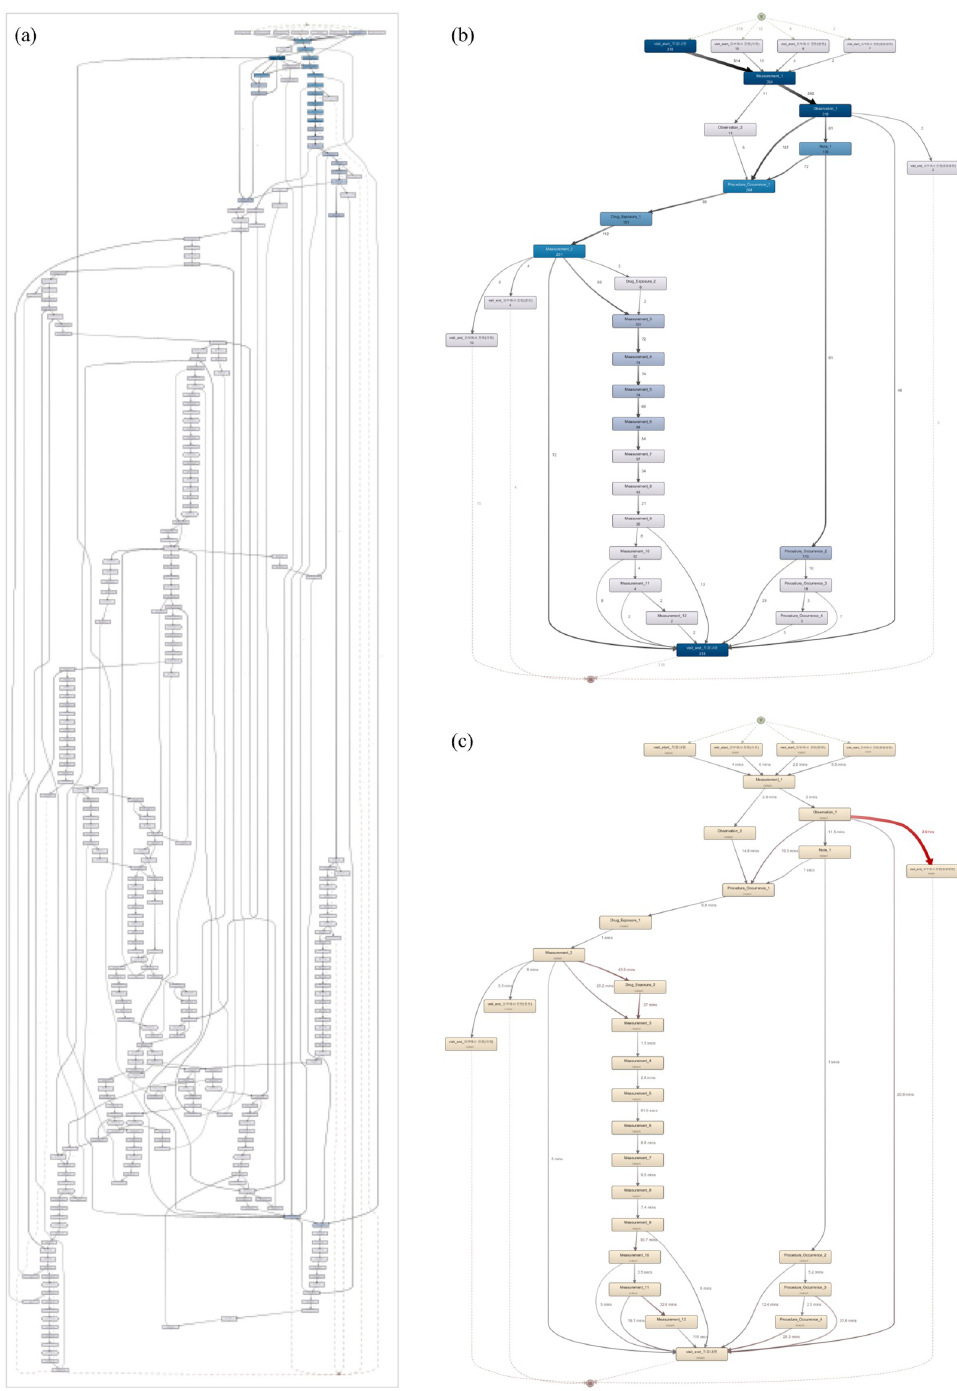
Fig 7. Emergency room process. (a) Process model with all activities included; (b) Process model with mainstream behaviors only; (c) Process model with mainstream behaviors only, based on median time duration between events.